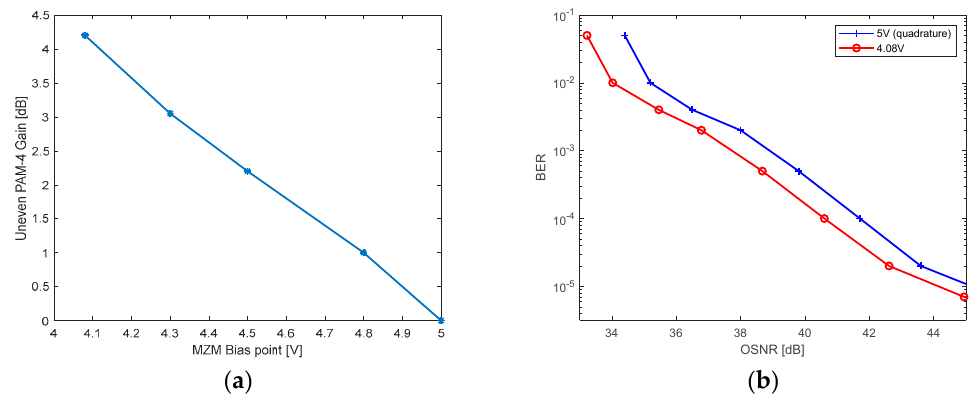
Figure 5. ( a ) Uneven PAM-4 gain vs. MZM bias point. ( b ) OMAouter improvement (only), by keeping power levels spacing of both curves identical.